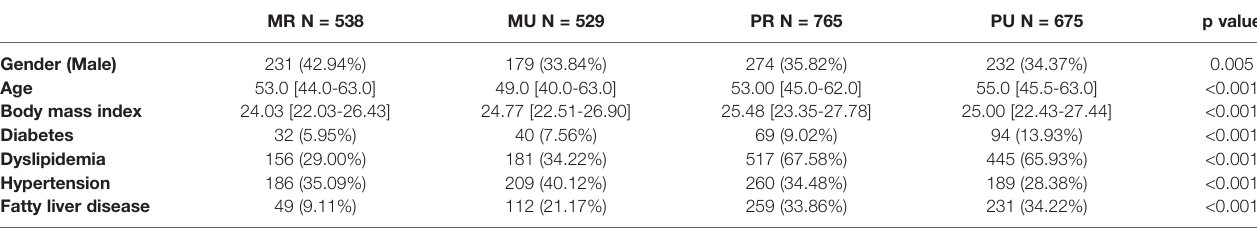
TABLE 1 | Clinical characteristics of participants in this